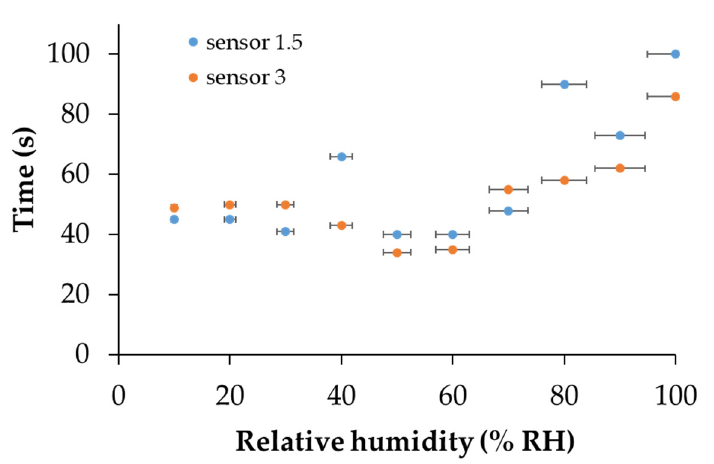
Figure 10. Response time for sensor 1.5 and sensor 3 when relative humidity increased with 10% RH steps in the second run of the sensor.